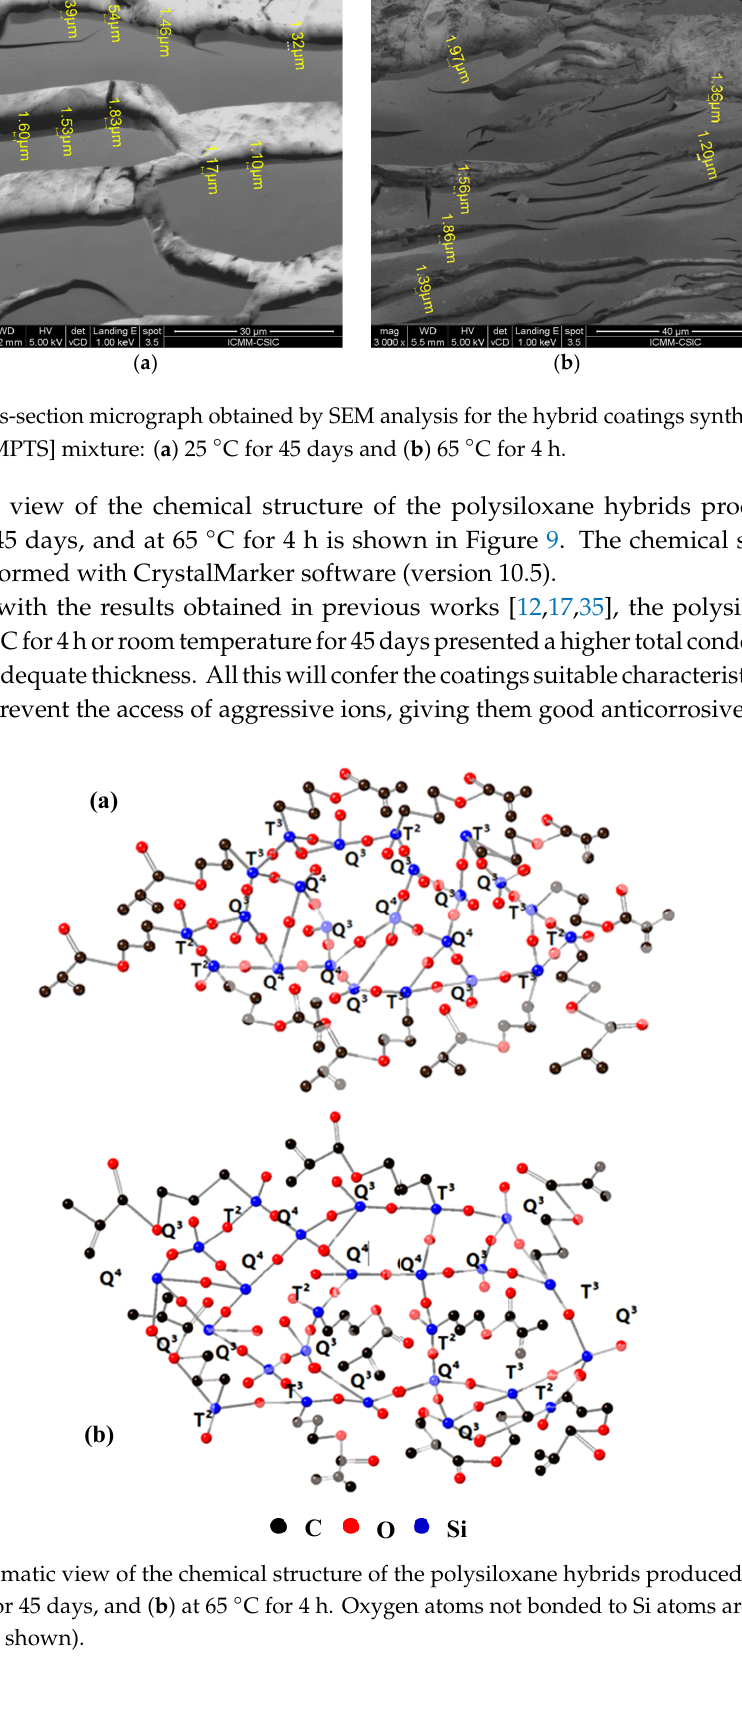
Figure 8. Cross-section micrograph obtained by SEM analysis for the hybrid coatings synthesized